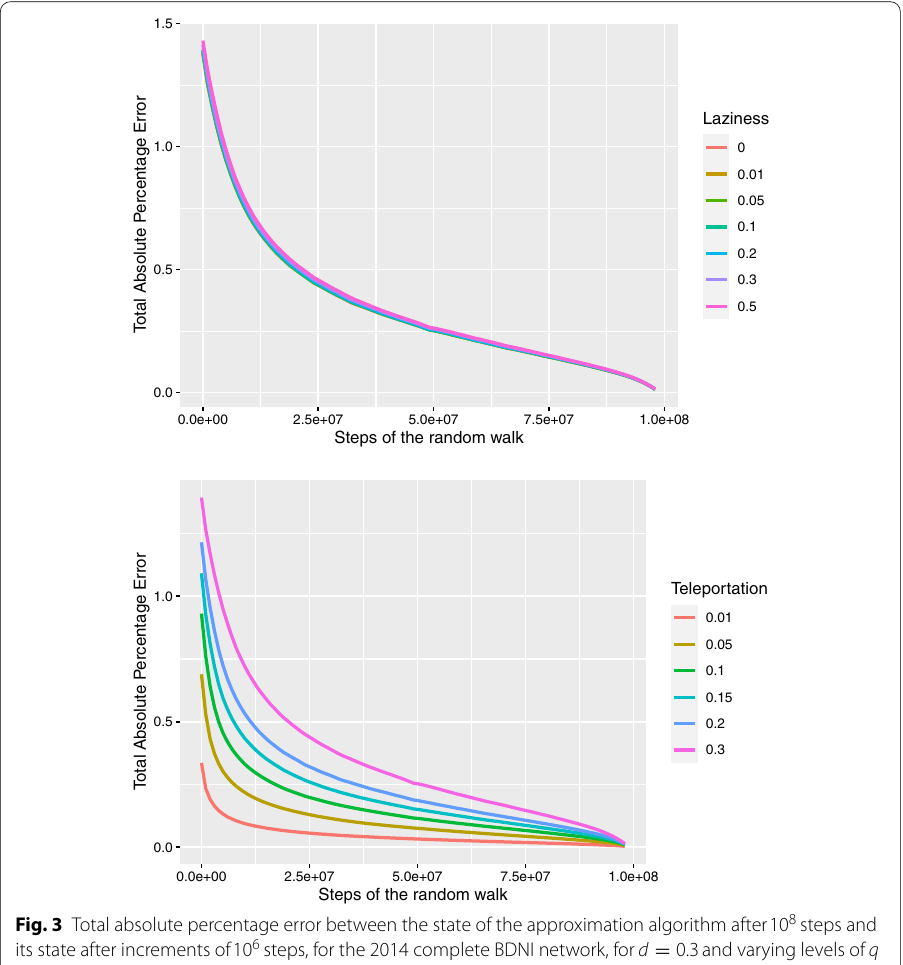
Fig. 3 Total absolute percentage error between the state of the approximation algorithm after 10 8 steps and its state after increments of 10 6 steps, for the 2014 complete BDNI network, for d = 0.3 and varying levels of q (top), and q = 0.1 and varying levels of d (bottom)